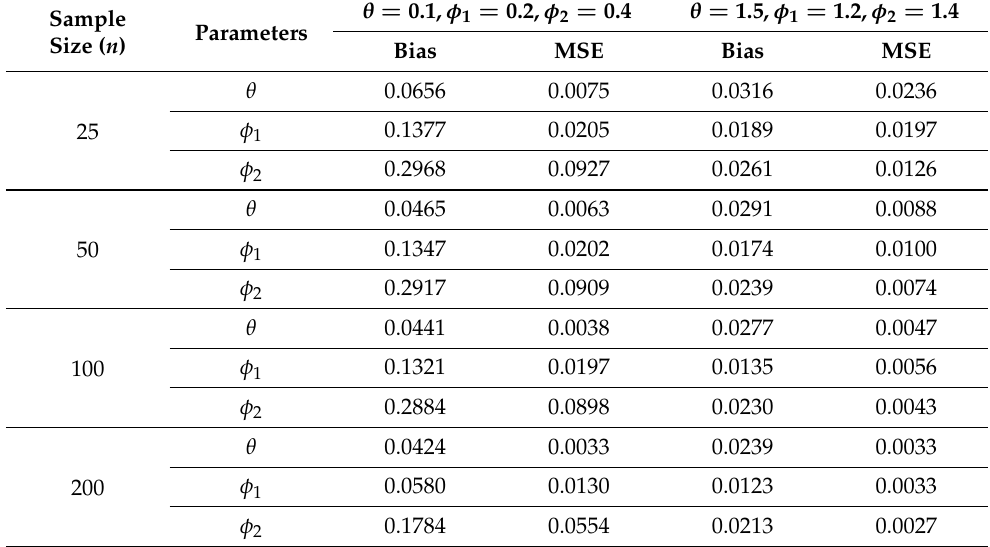
Table 1. Simulation results for the BP2S-L(I)